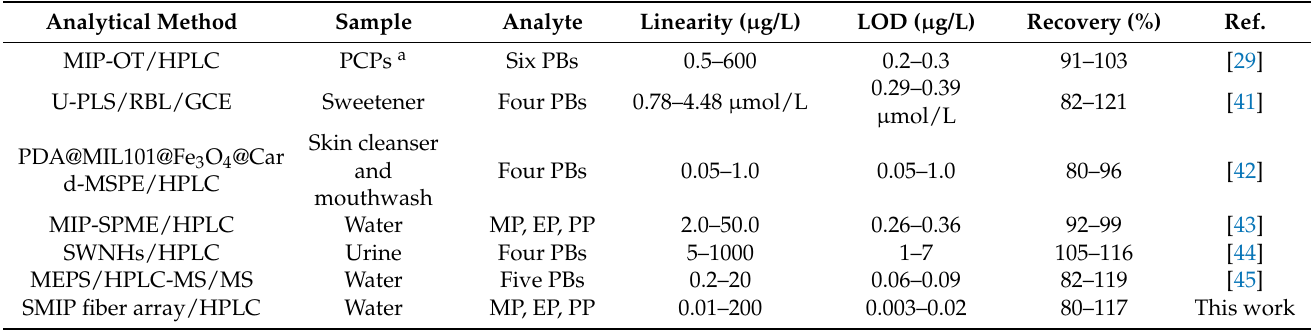
Table 6. Comparison of the developed method with other reported methods for